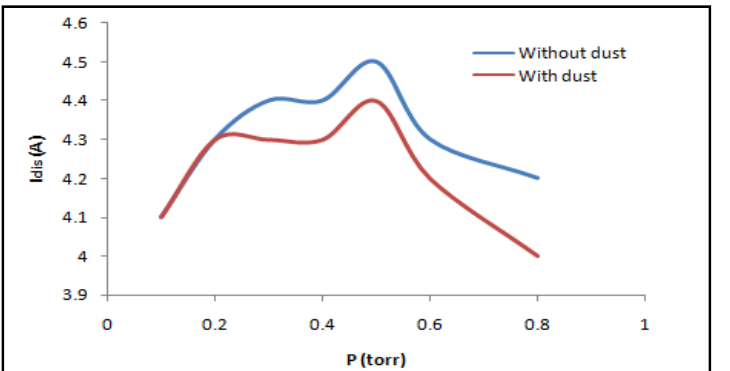
Fig.5: Schematic of the discharge current as a function of pressure at presence and absence of dust particles.